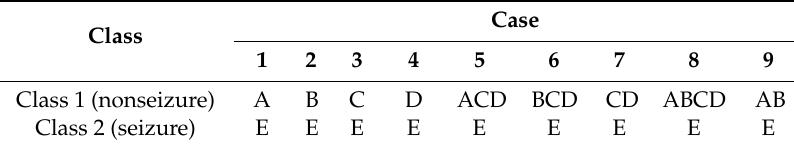
Table 2. Di ff erent cases derived from the dataset for epileptic seizure